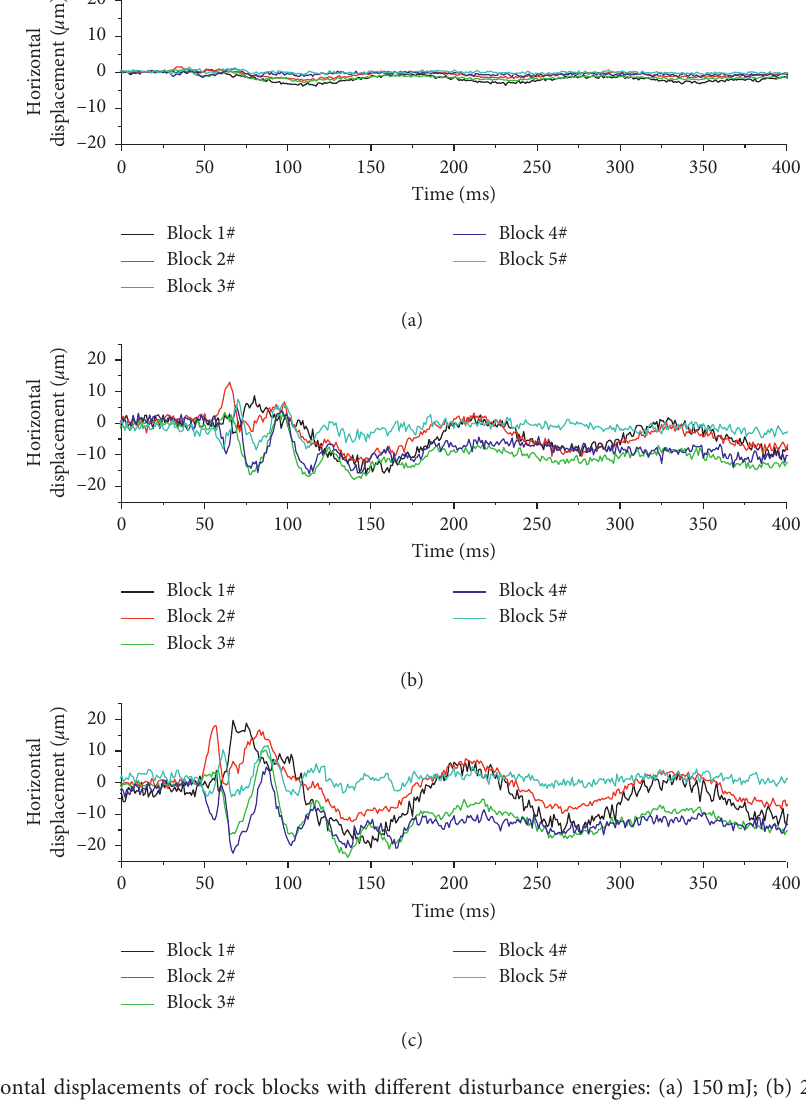
Figure 8: Horizontal displacements of rock blocks with different disturbance energies: (a) 150mJ; (b) 250mJ; (c)